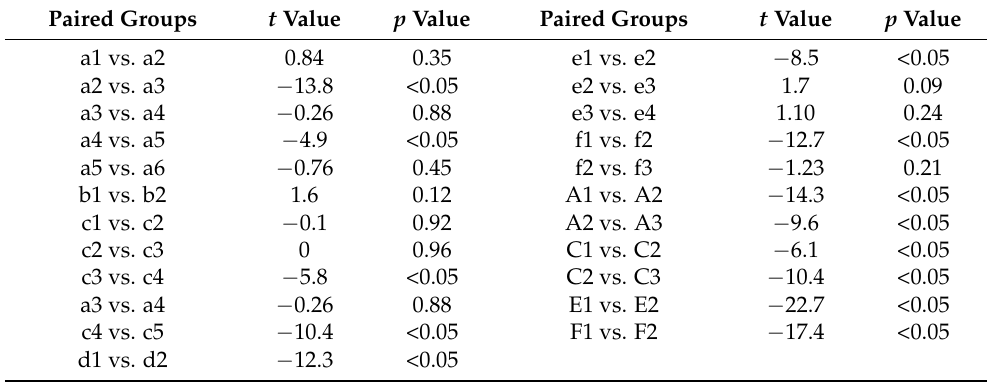
Table 2. The results of paired samples t -test of noise annoyance between different groups.